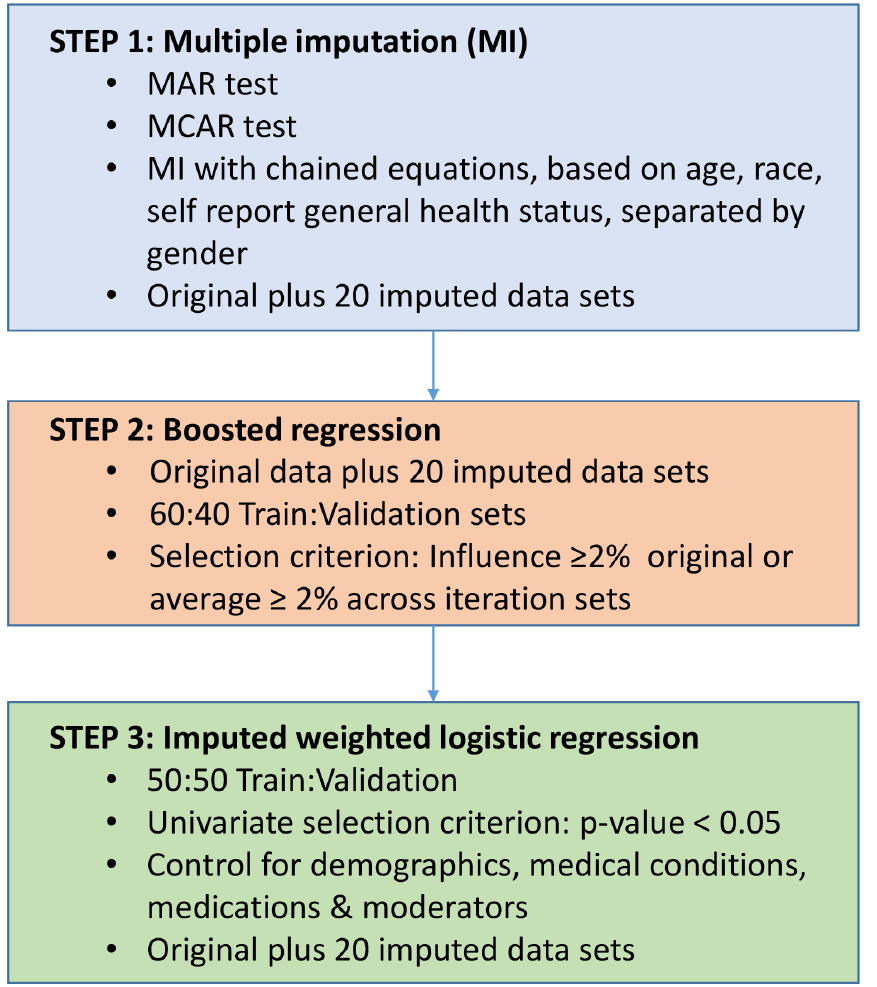
Fig 1. Hybrid Methodology